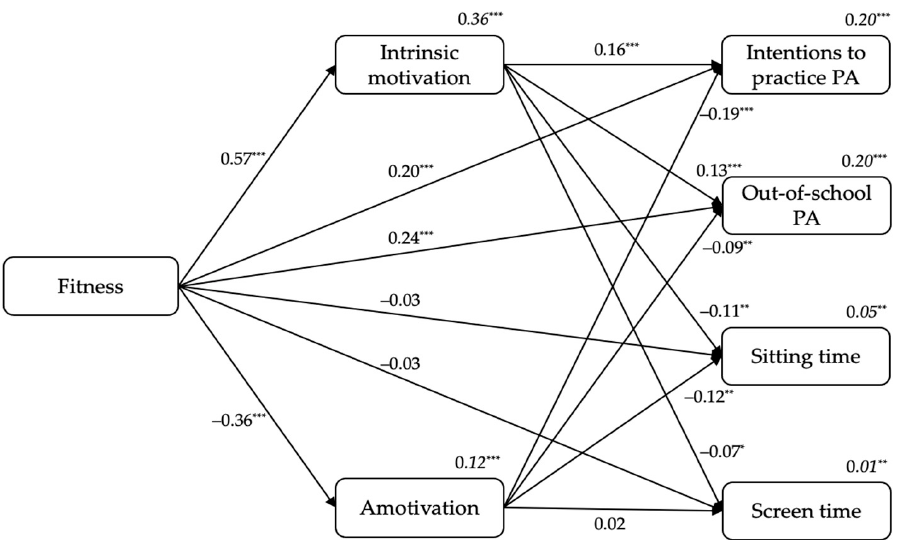
Figure 1. The standardized coefficients from students’ fitness to intrinsic motivation and amotivation, and to outcomes. Note . * p < 0.05. ** p < 0.01. *** p < 0.001. On the other hand, students’ sex included in the model as a covariate was a positive 0.05), out-of-school PA levels ( β = 0.13, p < 0.001), and a negative predictor of sitting time ( β = − 0.12, p < 0.001).